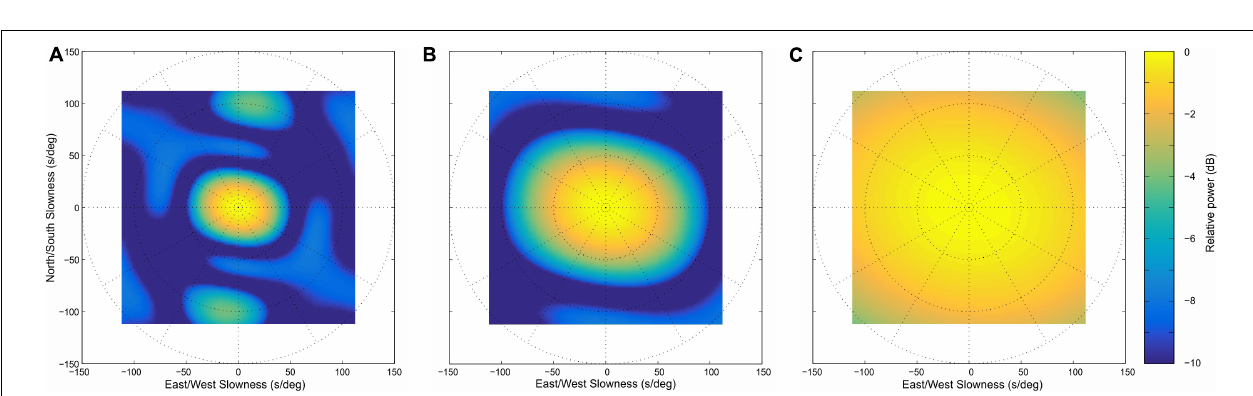
FIGURE 6 | Array response functions of the seven stations composing the summit ring of the Mt. Etna seismic permanent network (see Figure 1b ) for a unit amplitude incident wave with slowness of 0 s deg - 1 at periods of 2.5 s (A) , 5 s (B) , and 13 s (C) .